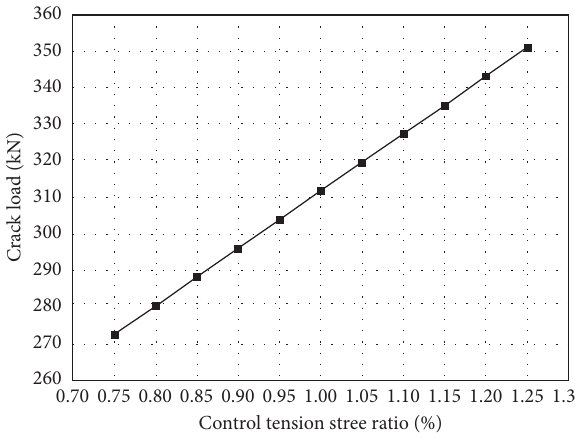
Figure 15: Te cracking load change with prestressing